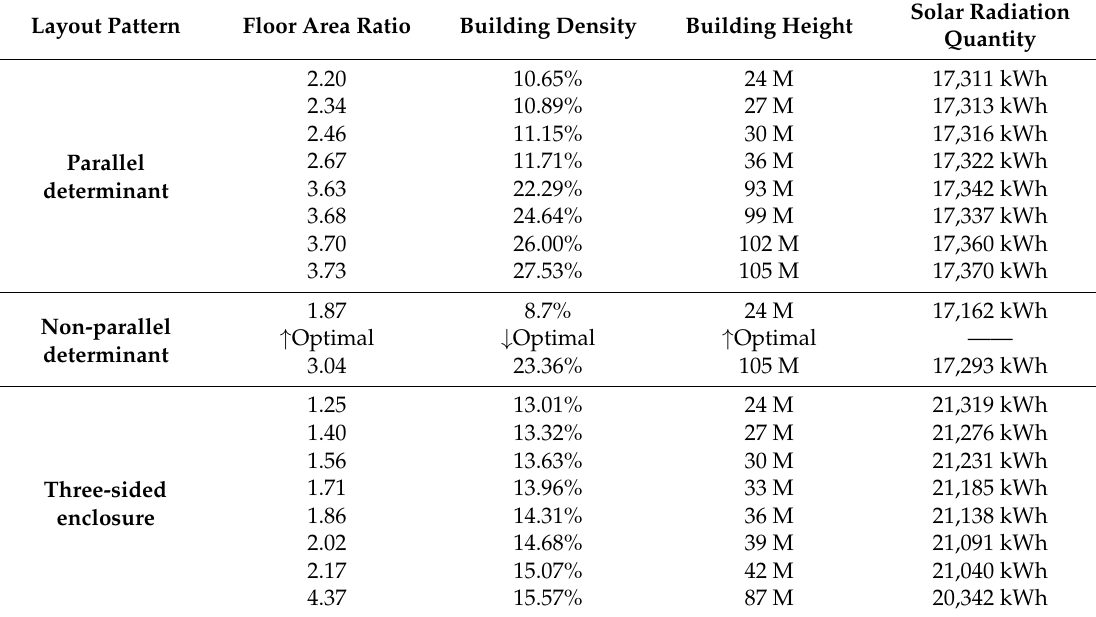
Table 2. Optimal combination on residential indicators of three layout